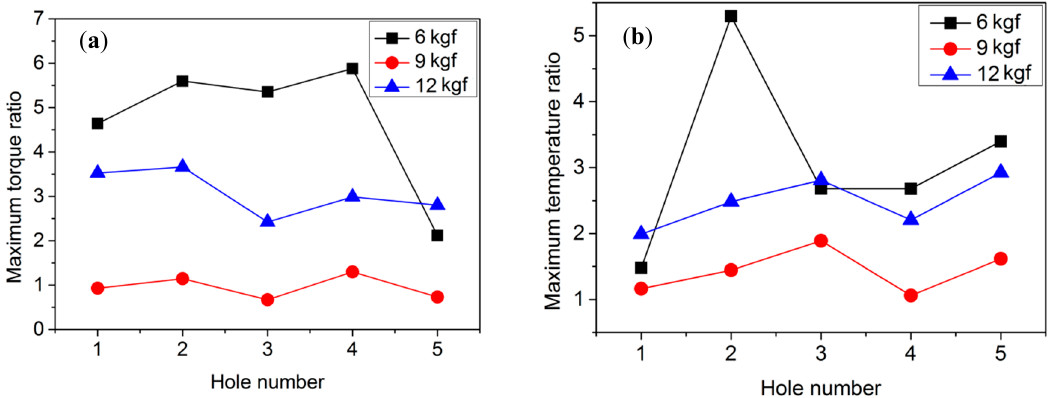
Figure 9. Maximum torque ratio ( a ) and maximum temperature ratio ( b ) with respect to hole number. Higher ratio means higher torque or temperature in CD compared with that in UAD.